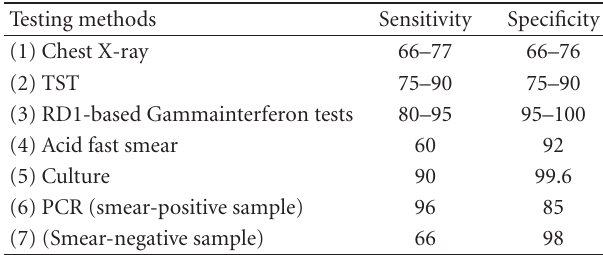
Table 1: Accuracy of various methods of diagnosis of tuberculosis with their sensitivities and specificities